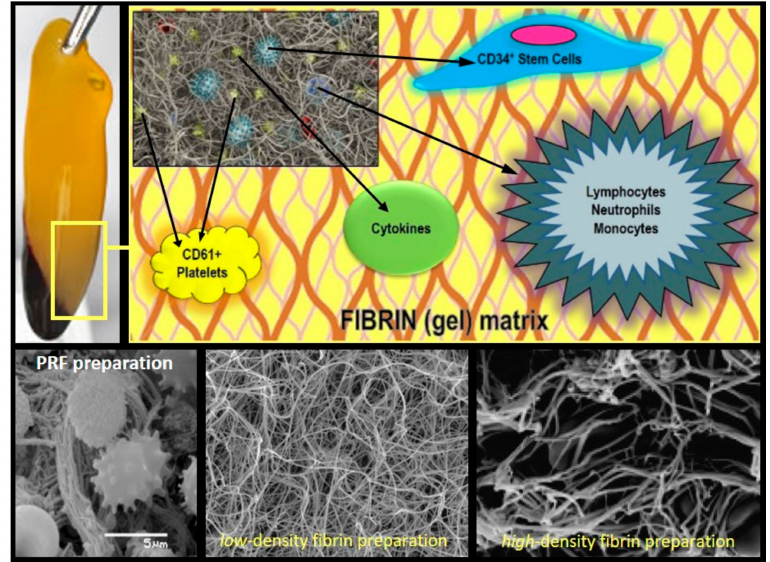
Figure 2. PRF Composition/Architecture Illustration. Schematic representation of PRF bio-components and SEM (scanning electron microscope) micrographs of the PRF membranes displaying its polymerized interconnected fibrin network and large living cell population